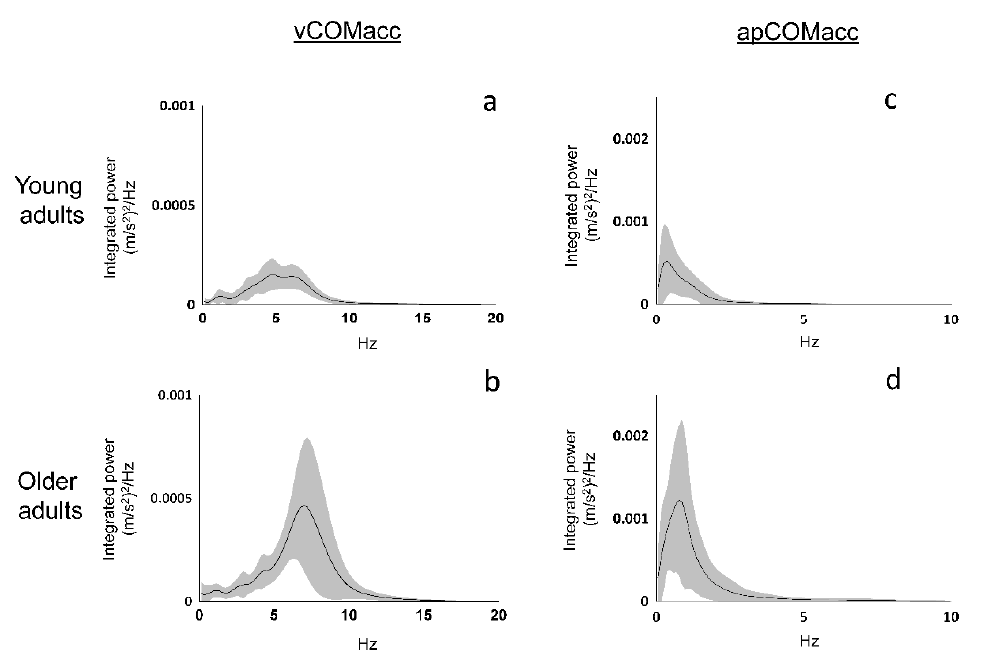
Figure 3. Power spectral density functions of vCOMacc (left panel) and apCOMacc (right panel). The upper and lower panels indicate the results for young adults (panel a , c ) and older adults (panel b , d ), respectively. The solid line represents the average in each frequency band of the group. The shaded area represents one standard deviation. Table 1. Summary of vertical center of mass acceleration (vCOMacc), integrated power spectral density (PSD), maximum amplitude (MA), root mean square (RMS), and correlation coefficient ( r ) for both age groups combined.